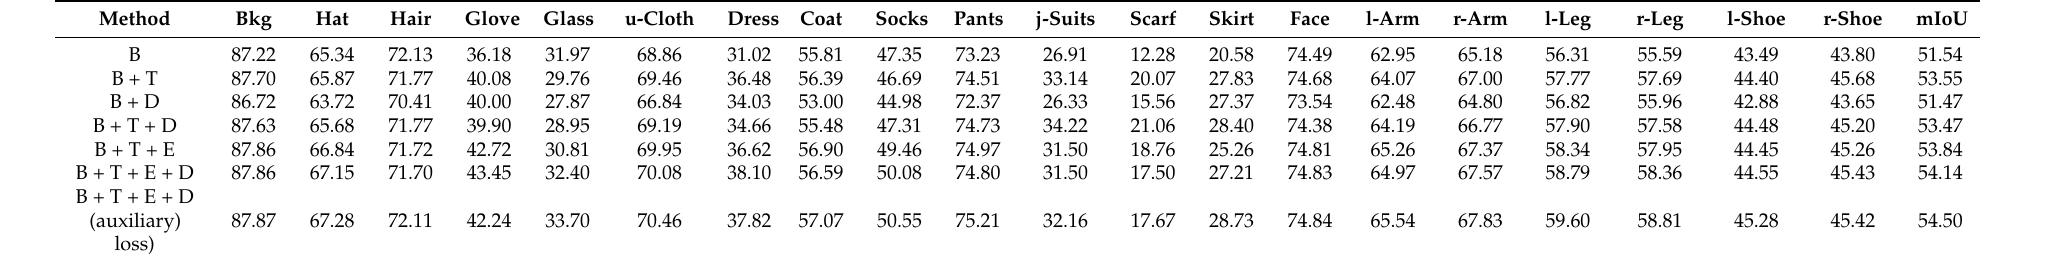
Table 5. Comparison of per-class IoU on the LIP validation set. “B” means baseline module; “T” means GTM; “E”, “D” denote edge detection module and DFE module.